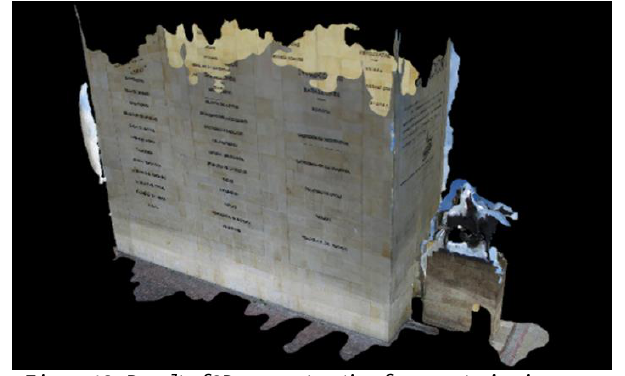
Figure 13: Result of 3D reconstruction from capturing images from the full view surface.